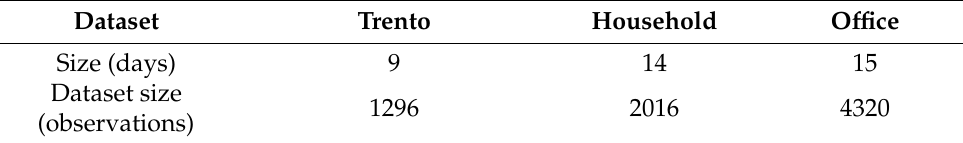
Table 3. Datasets